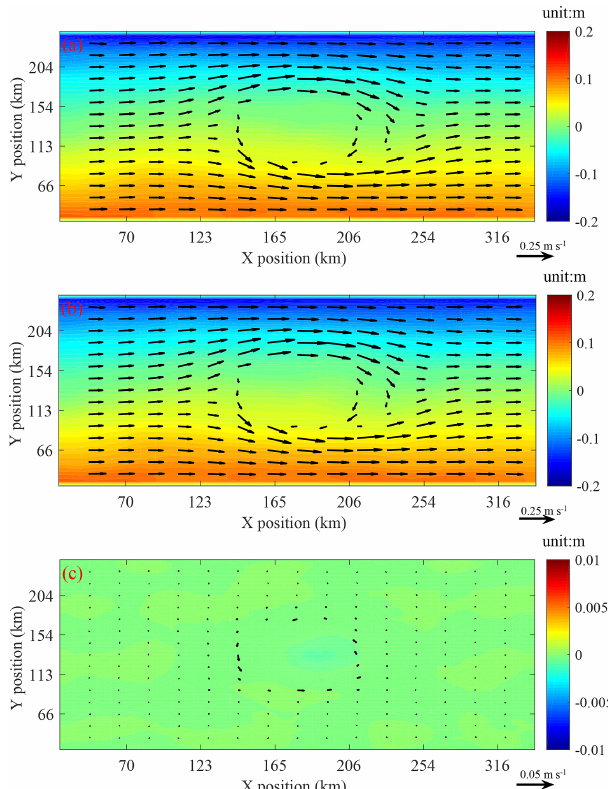
Figure 11. Comparison of the surface elevation (shaded) and cur- rents at 3500m depth (vector) between GOMO and sbPOM on the 4th model day. (a) GOMO, (b) sbPOM, and (c)